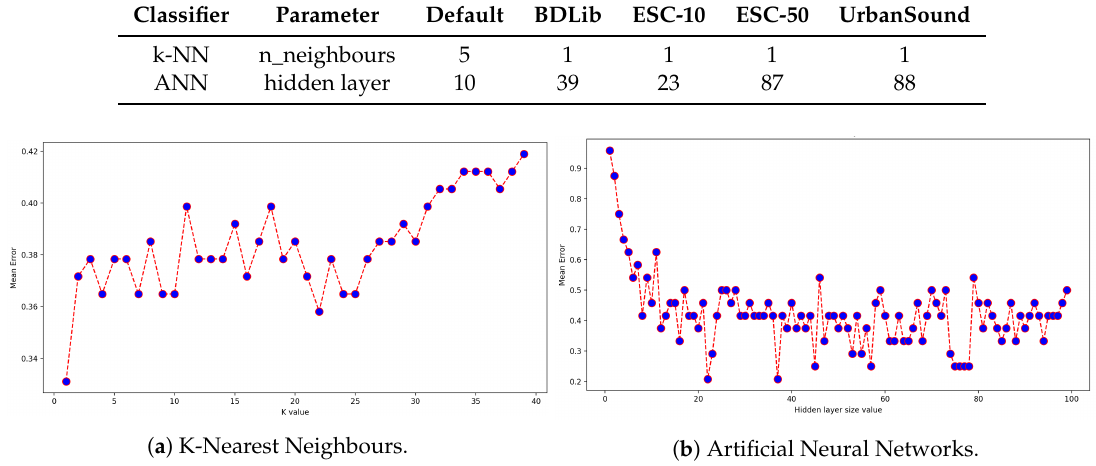
Figure 5. Exploration of the classifiers’ parameters for the BDLib dataset. The k-NN and ANN classifiers are optimized by selecting the value of the parameter leading to the minimal mean